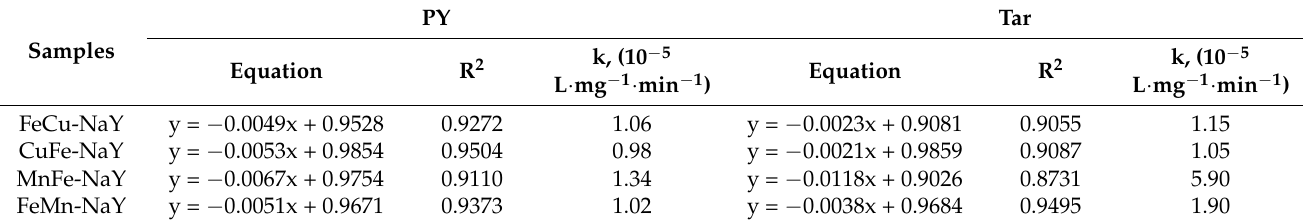
Table 5. Kinetic results for bimetallic catalysts obtained at 40 ◦